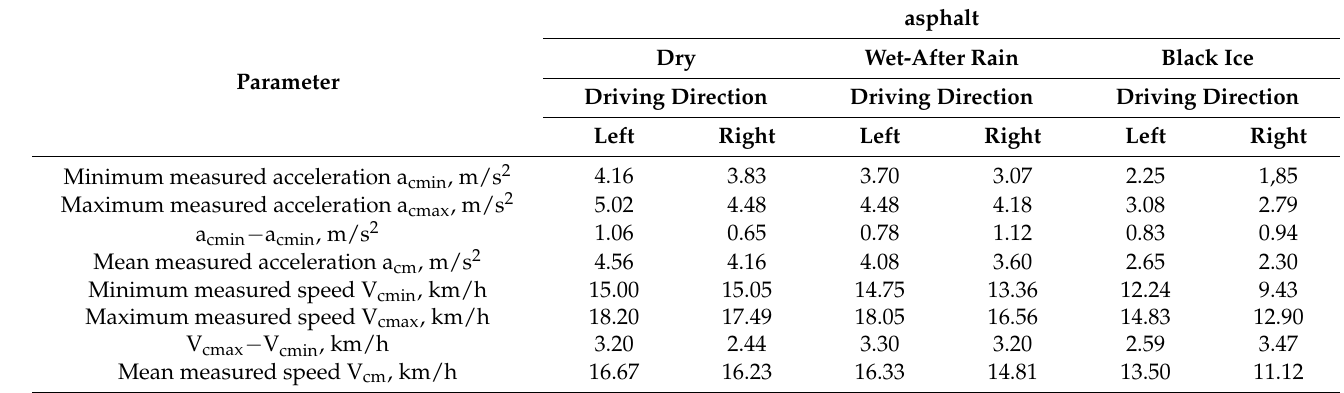
Table 10. The Ford Transit’s lateral accelerations and speeds when driving in a circle with the highest possible speed on a dry, wet (after rain) and icy asphalt surface. asphalt Dry Wet-After Rain Black Ice Parameter Driving Direction Driving Direction Driving Direction Left Right Left Right Left